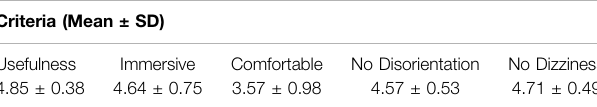
TABLE 1 | VR user experience